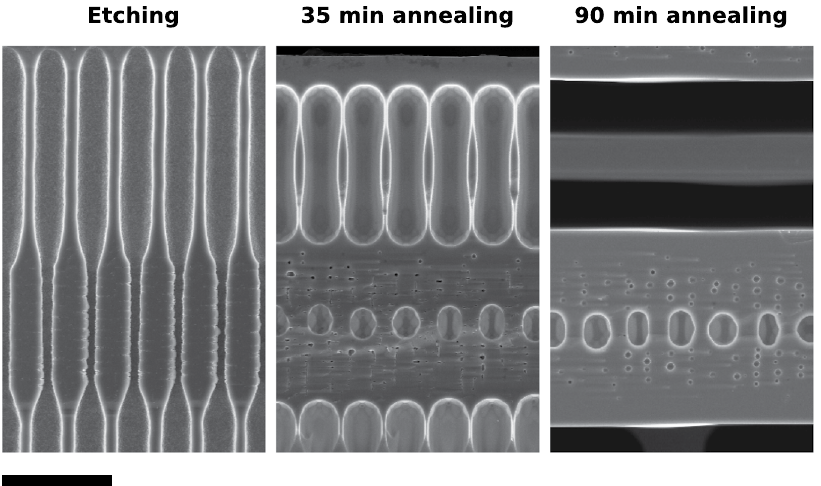
Figure 5. Cross-sectional view SEM images of different samples with identical starting profile after different annealing times, revealing the evolution of a structure with a large separation void which develops into a spurious layer. Scale bar is 5 µ